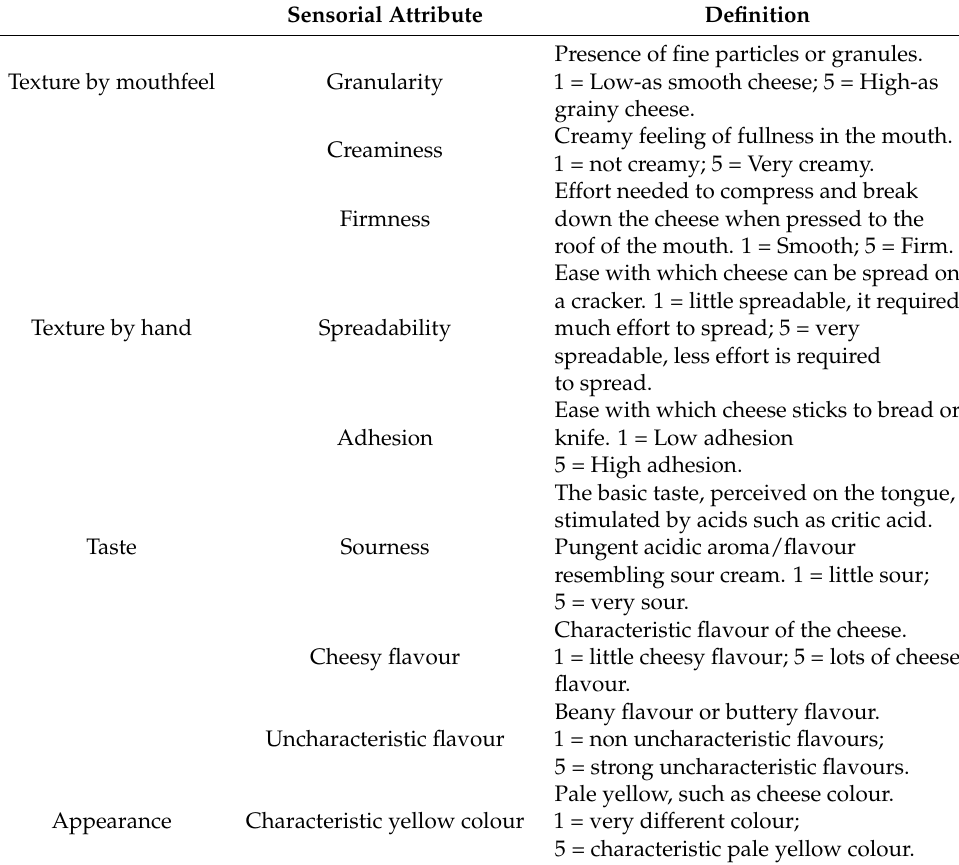
Table 1. Sensory descriptors for the spreadable cheese